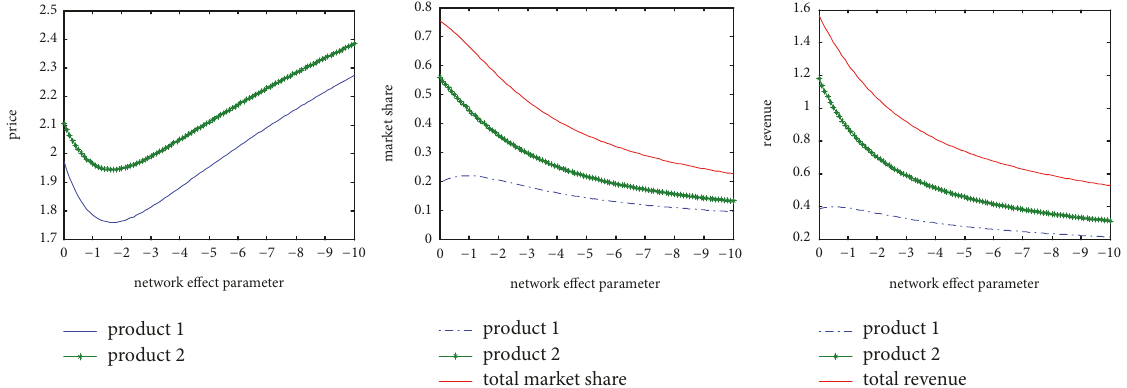
Figure 5: The influence of the network effect parameter on the optimal solutions.